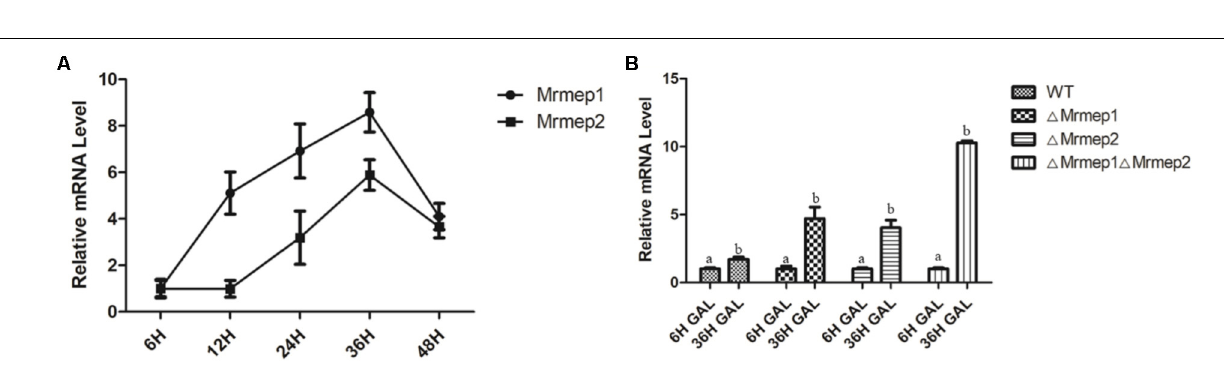
Frontiers in Microbiology |